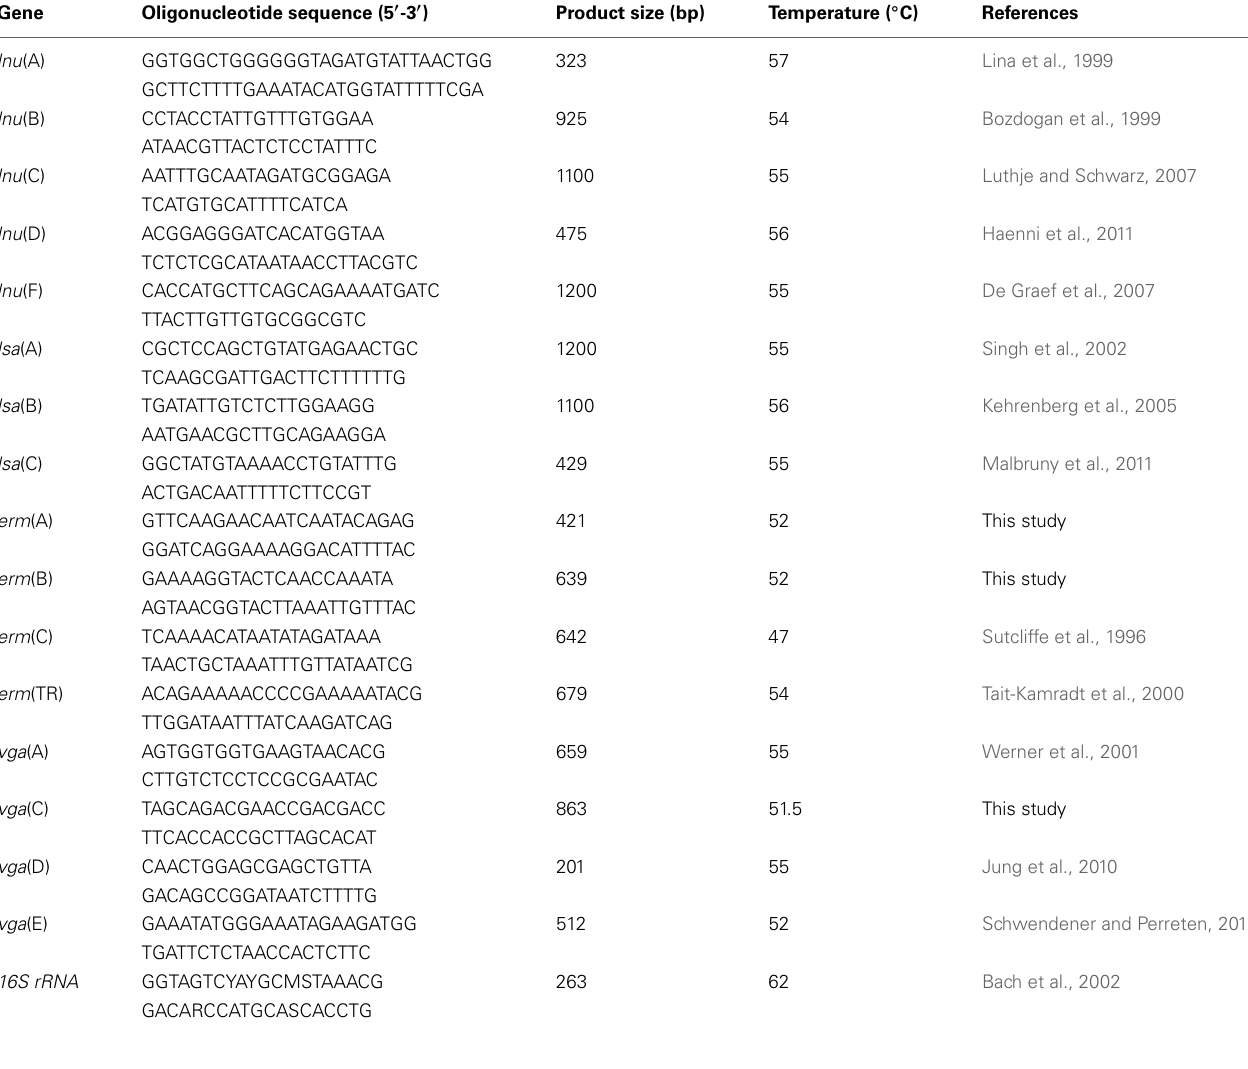
Table A1 | PCR (QPCR) primers and conditions used in this study. Gene Oligonucleotide sequence (5 (cid:2) -3 (cid:2) ) Product size